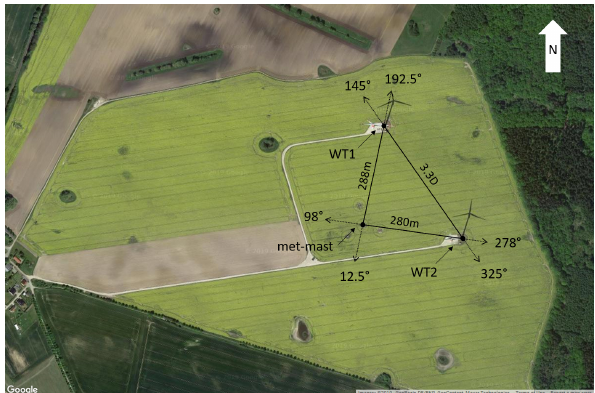
Figure 2. Satellite view of the test site, including waking directions and distances. WT1 indicates the turbine used for the present anal- ysis (© Google